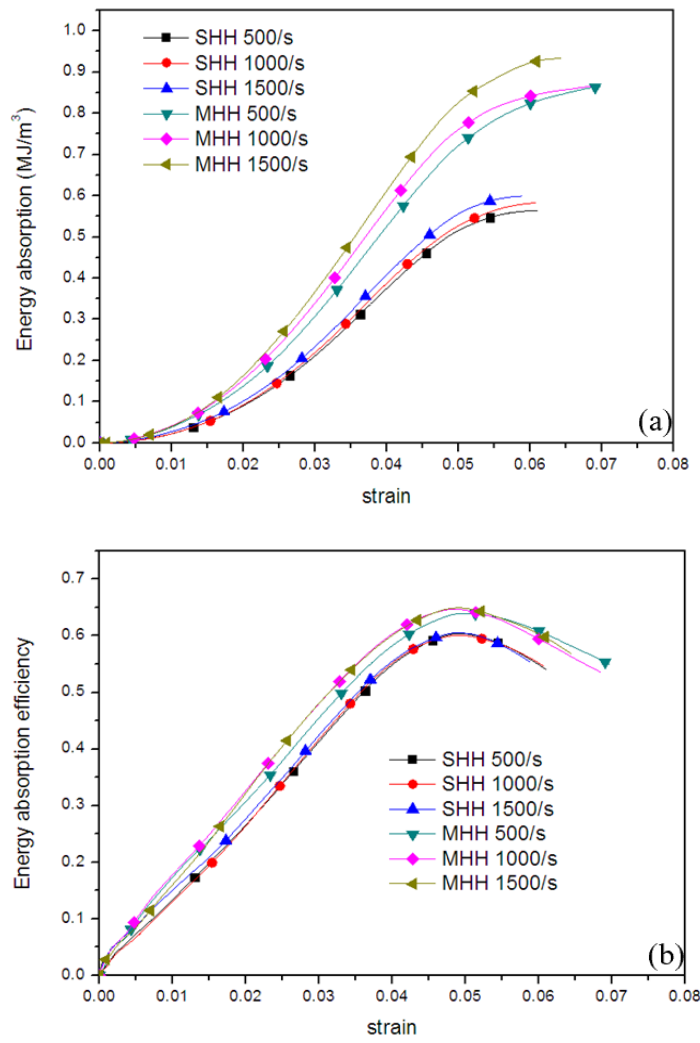
Figure 13. Energy absorption properties of resin honeycomb materials under dynamic loading of different strain rates: ( a ) Energy absorption, ( b ) Energy absorption efficiency.